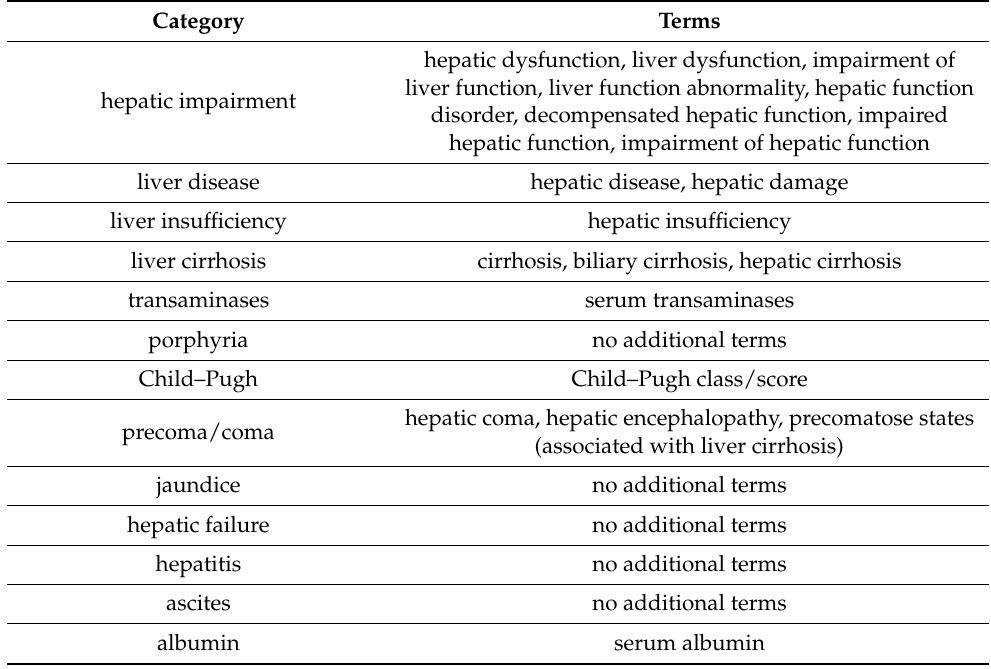
Table 1. Category names and terms that were assigned to the respective categories. English terms only. Complete list (German and English terms) available in Supplementary Table S2.